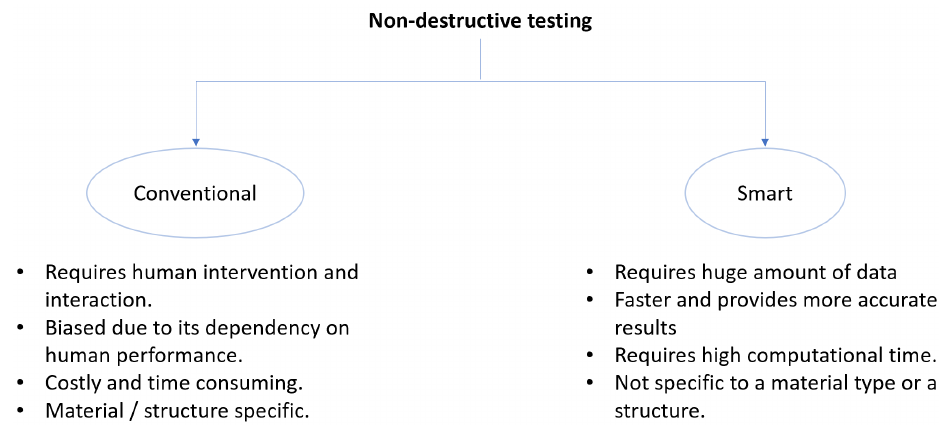
Figure 7. A comparison of conventional and smart inspection using nondestructive testing tech-